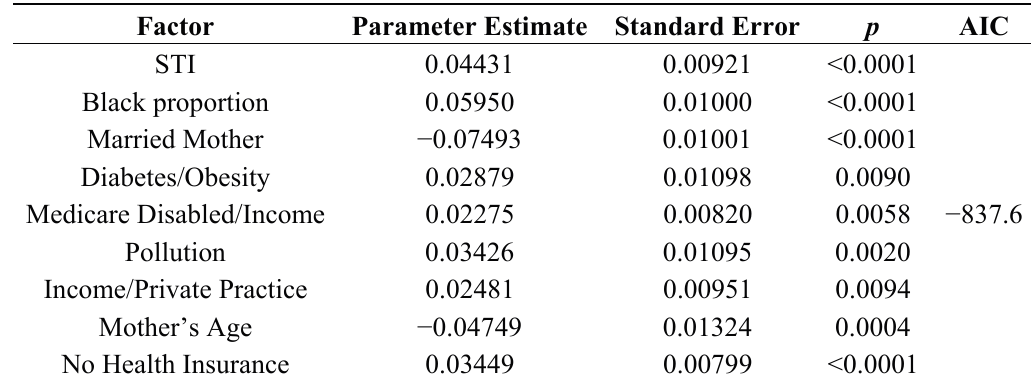
Table 2. Final regression model of outcome logit county prematurity percentage and extracted factors as independent variables using a spherical covariance matrix (N = 512 counties).